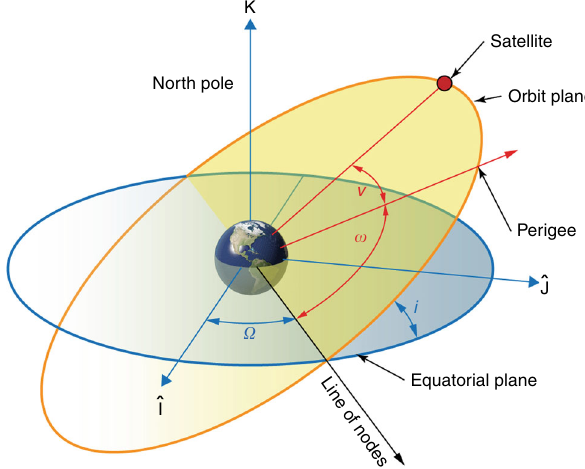
Fig. 5 Angular orbital elements referred to in this study. Inclination ( i ) is the angle at which the orbit is tilted out of the equatorial plane. Right ascension of the ascending node ( Ω , RAAN) is the angle of rotation around the Earth spin axis referenced by convention to the direction of the sun at the vernal equinox. The argument of perigee ( ω ) describes the position of the perigee point relative to the point on the orbit which ascends across the equator. True anomaly ( ν ) is the angle in the orbit plane between a satellite at an instant in time and perigee. In addition to these angular elements, the semimajor axis ( a ) and eccentricity ( e ) describe the size and shape of the orbit,